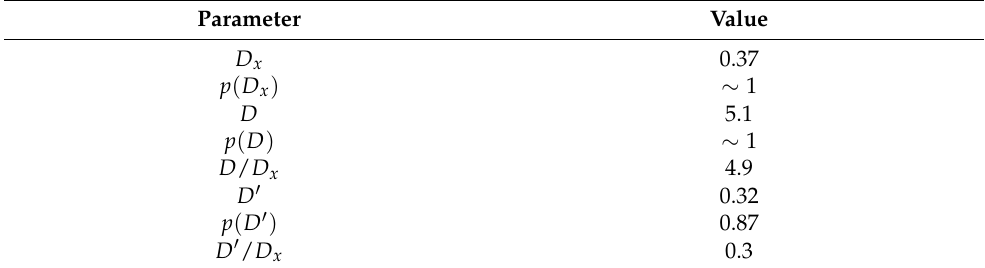
Table 1. The experimental delay calculation results for I&C system component Z.